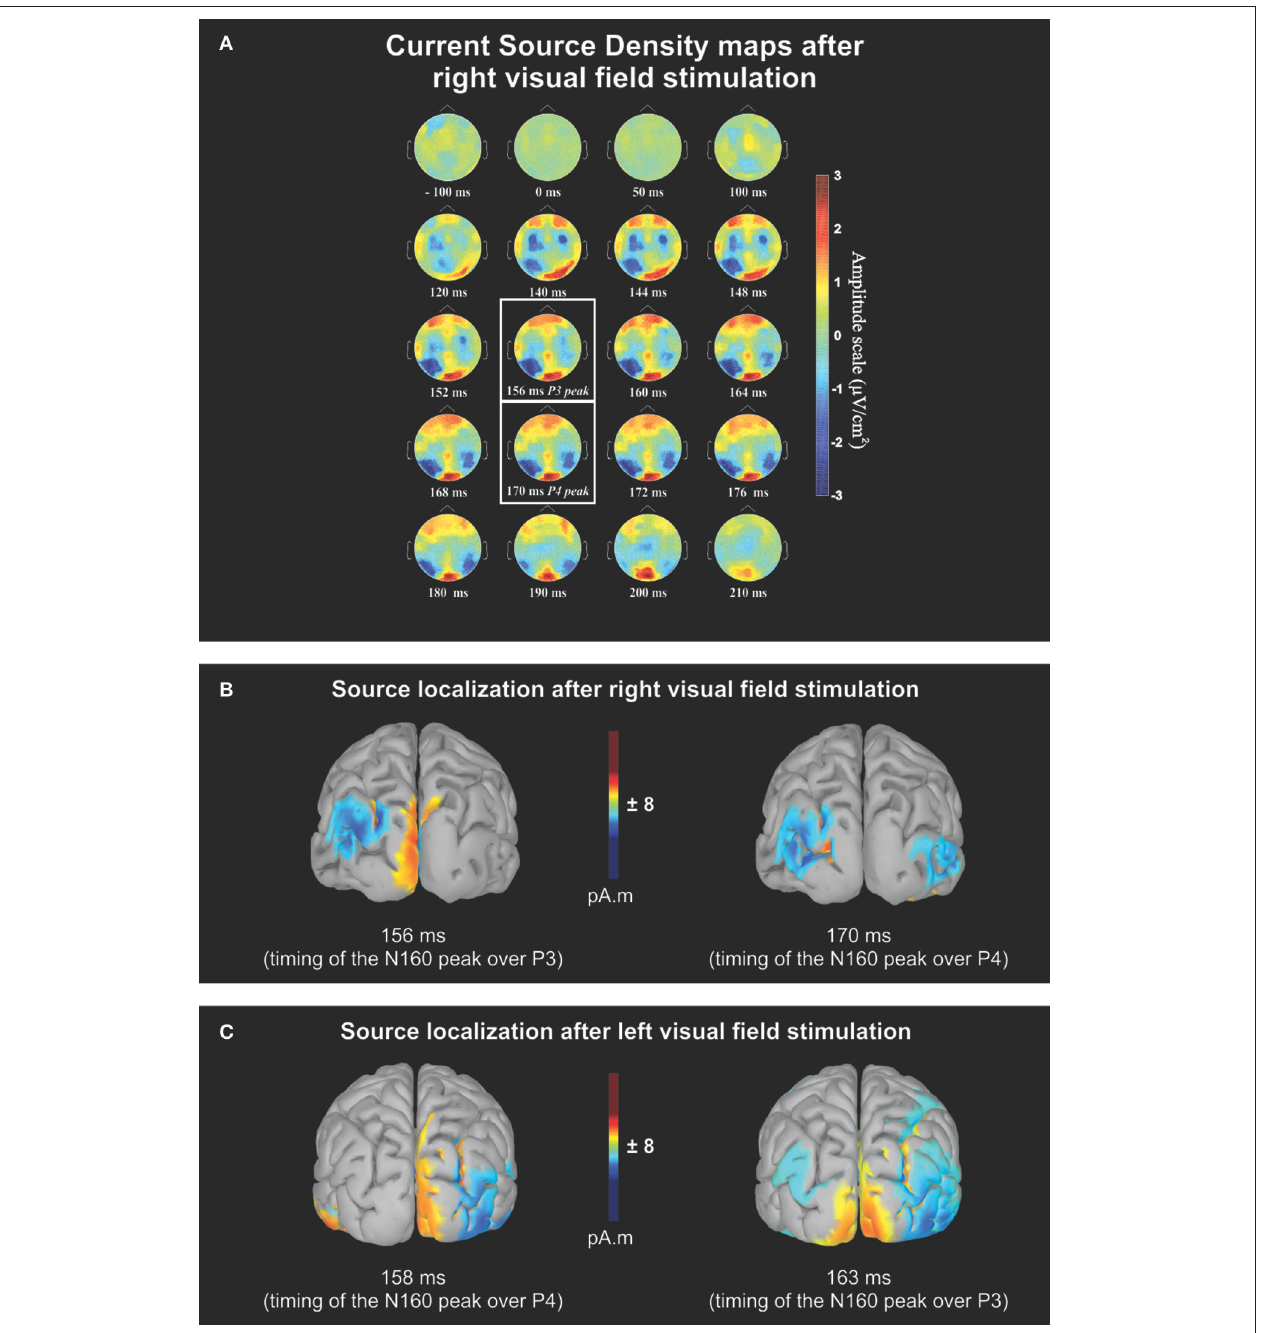
FIGURE 2 | Qualitative overview based on the averaged data of the 11 right-handers with a right dominant eye. (A) Sequential current source density (CSD) maps from 100ms before to 210ms after right visual field stimulation. The maps are presented for different times with closer intervals (between 140 and 180ms) for the period where peak negativity (N160) was expected. The two white boxes contain the maps recorded at mean latency of the maximum negative deflection recorded over P3 and P4 electrodes. Blue and red areas on the maps correspond to negative and positive voltage, respectively. Note that the activation of the contralateral hemisphere with respect to the stimulation precedes the ipsilateral hemisphere activation by a few milliseconds. Activations over sensori-motor cortices (C3 and C4 electrodes) occurring earlier than posterior N160 are thought to be related to visuo-motor integration. (B) Estimated source maps on the cortical surface (LORETA) at the N160 latency based on the grand average after right visual field (RVF) stimulations and (C) after left visual field (LVF) stimulations. In both conditions, source localization shows an interhemispheric transfer ∼ 160–170ms, after the visual stimulation, occurring in the medium/superior occipital gyrus (Brodmann area 19). For the sake of clarity, only activity sources that were 11% above minimal activation are